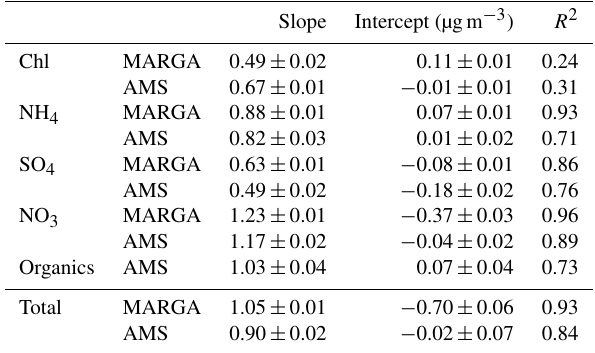
Table 1. Results of the ACSM to MARGA and ACSM to AMS comparisons for individual species and the respective total masses. Note that for comparison with the MARGA total mass concentra- tions only the ACSM inorganic species were